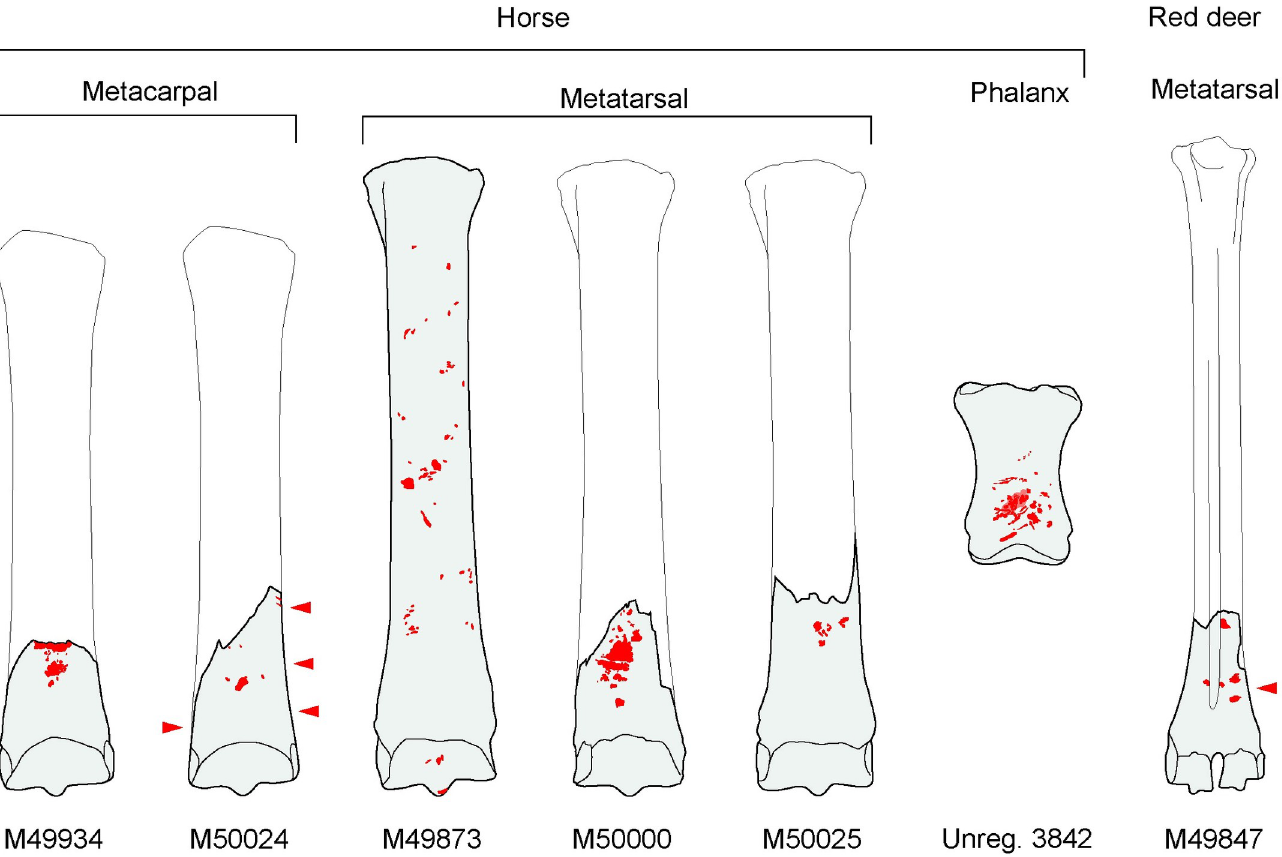
Fig 11. Schematic outlines of postcranial bones from Gough’s Cave used as knapping tools. Red indicates knapping damage; arrows mark the location of impact features on the side of the bone. Note the consistent pattern of breakage of the metapodial shafts close to the distal articular